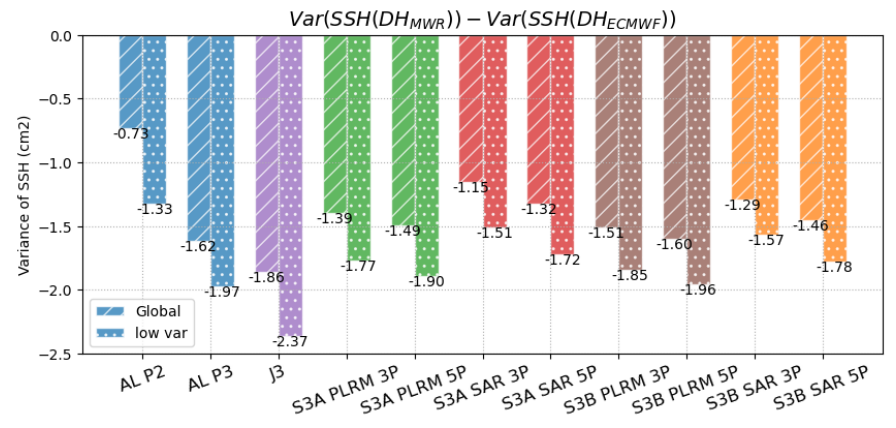
Figure 16. Difference of variance of SSH at crossover points for AL, J3, S3A, S3B for global and low oceanic variability selections.